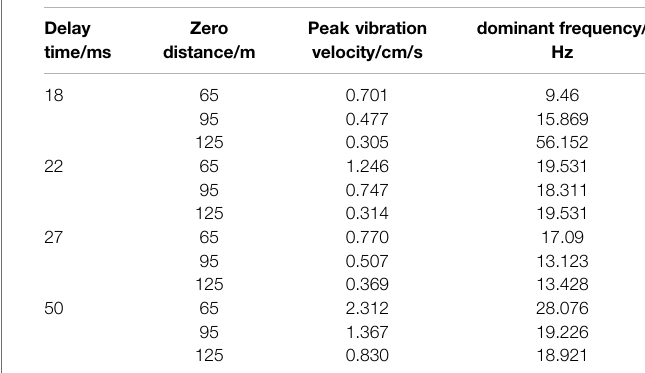
TABLE 3 | Blasting vibration velocity data at each measuring point with different delay times.